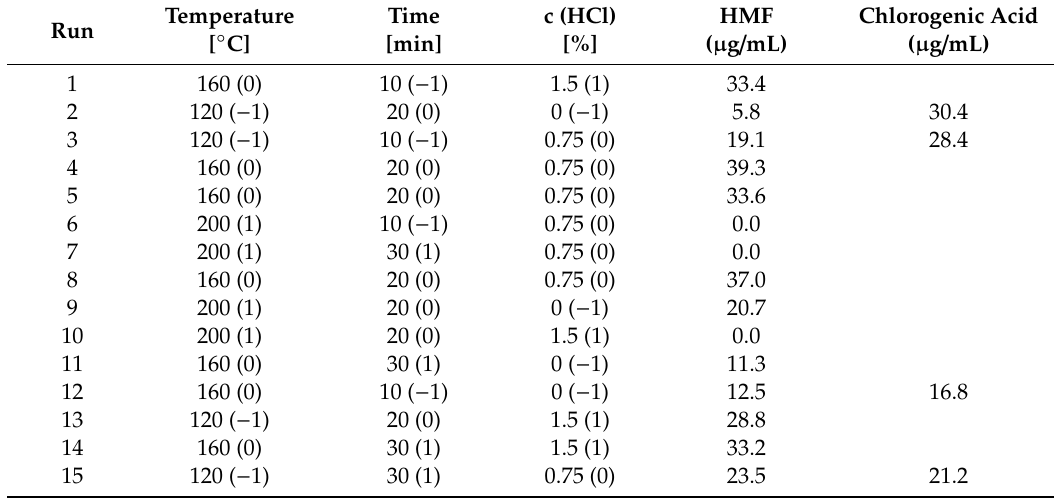
Table 5. Concentration of hydroxymethylfurfural (HMF) and chlorogenic acid in obtained extracts of A. millefolium determined by